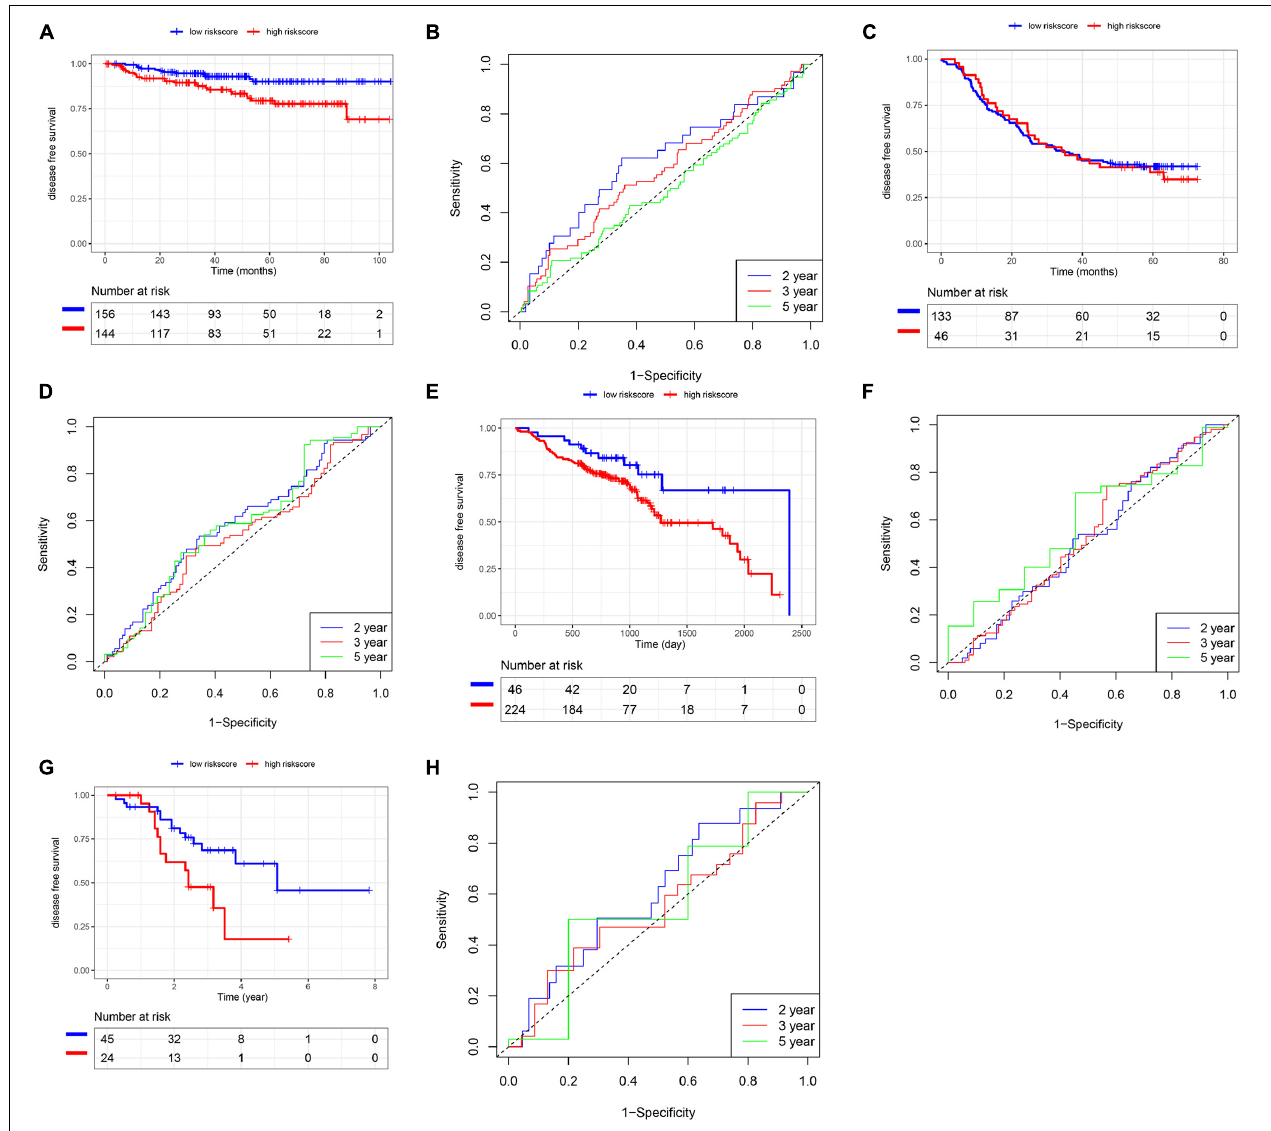
FIGURE 6 | Validation of the risk score model using SCC cohorts from the GEO database. (A,B) CSCC. (C,D) ESCC. (E,F) HNSC. (G,H)